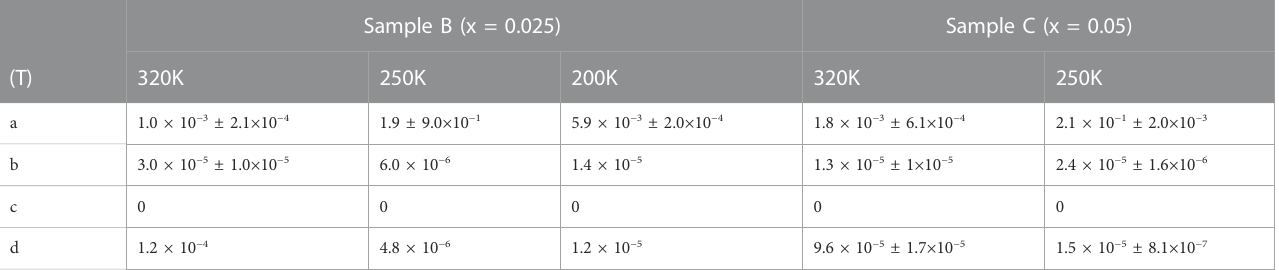
TABLE 1 Table shows parametric values obtained by data fi tting using Khosla and Fischer model of magneto-transport and experimental results of magnetoresistance variation in between -9 to 9T magnetic fi elds. Typical de fi nitions of the fi tting parameters a, b, c and d are described in the text. Sample B (x =